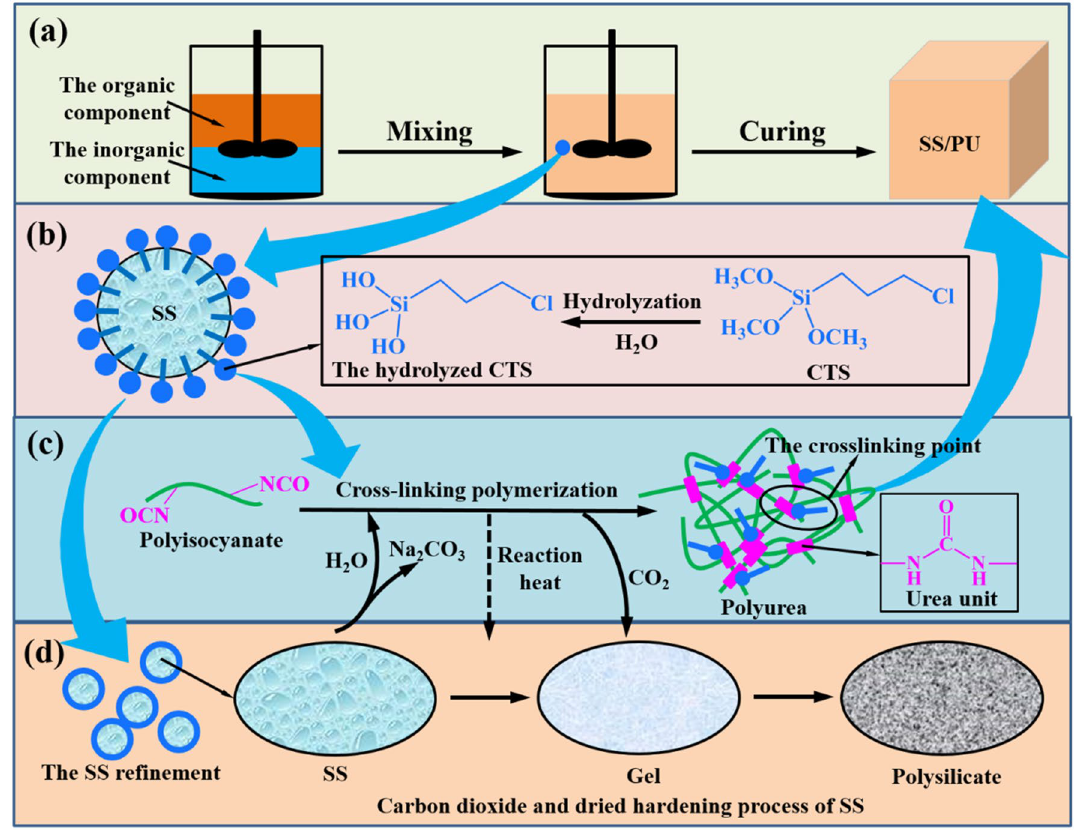
Figure 1. The proposed mechanism for the synthesis of CTS modified SS/PU